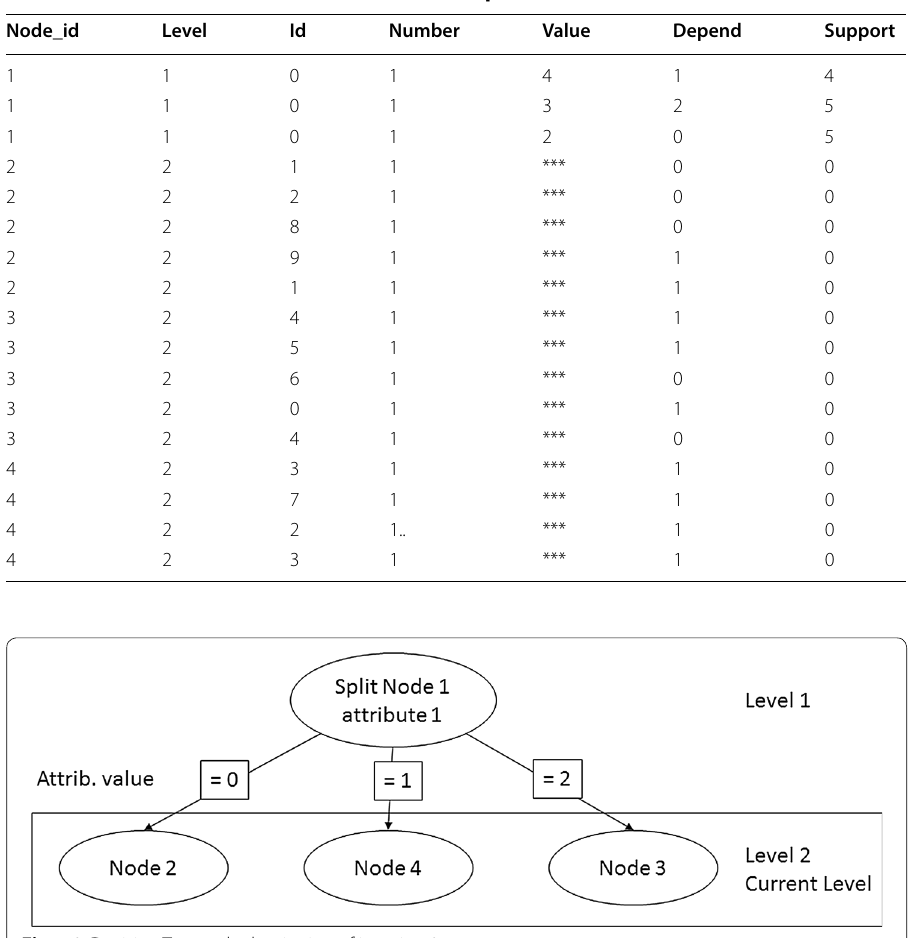
Table 3 Node-instance records of iteration 2’s input